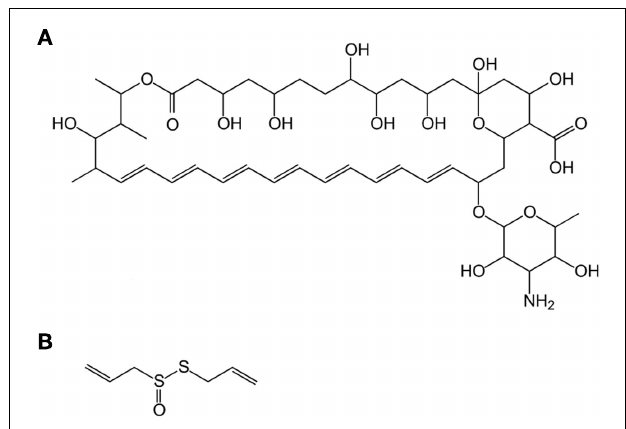
FIGURE 1 | Structures of amphotericin B (AmB) (A) and allicin